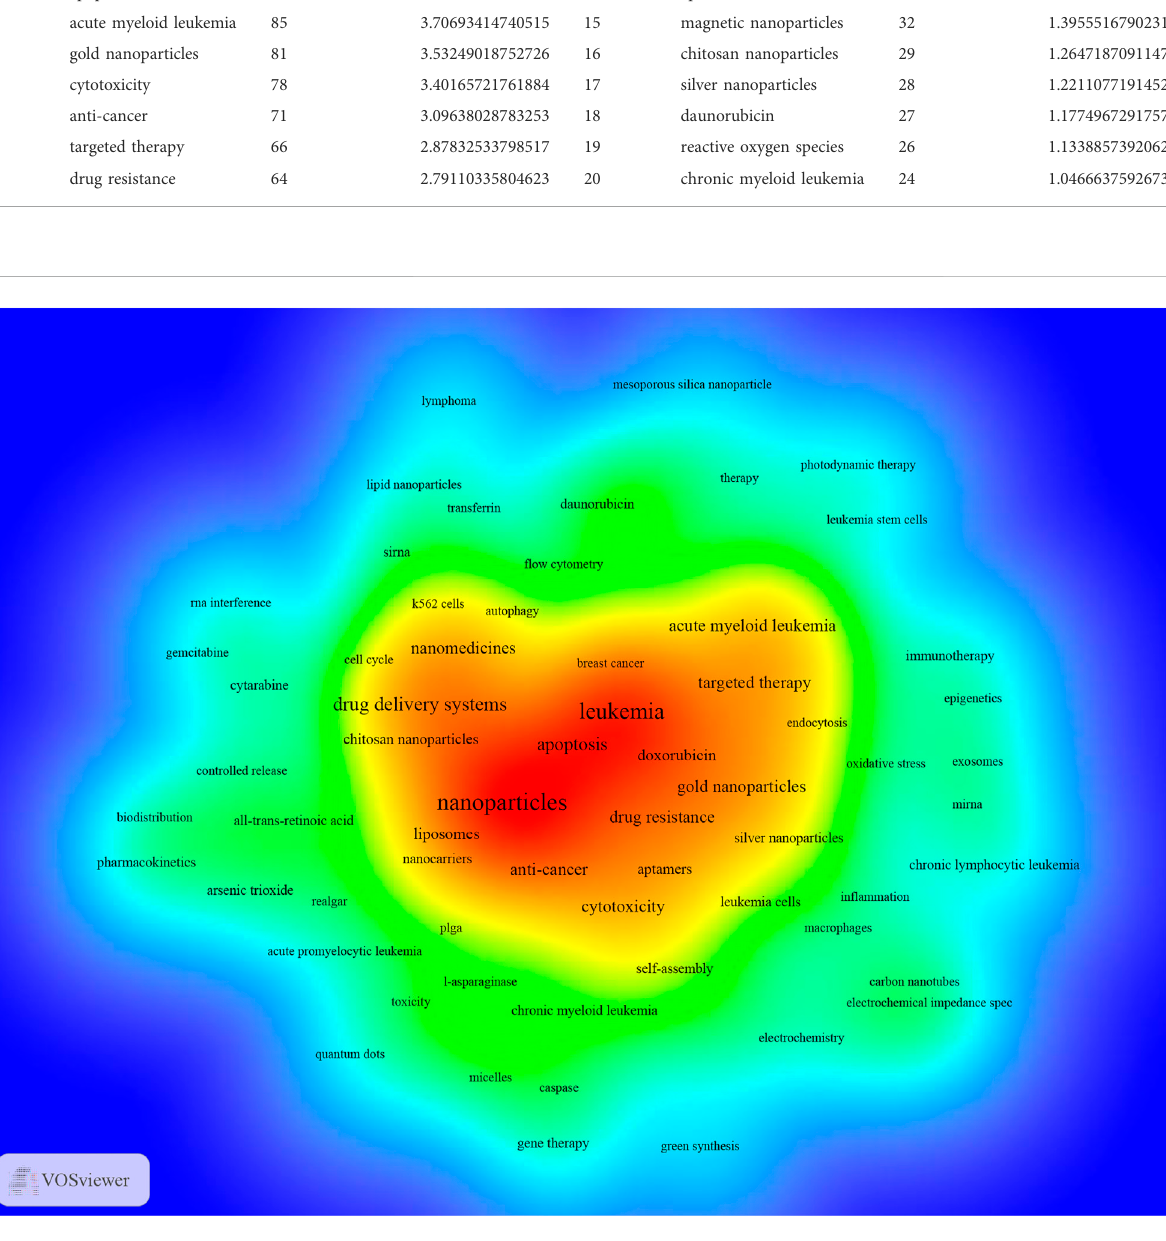
FIGURE 6 The density map of keywords in Nanoparticles-leukemia research (T ≥ 9). Notes: The word ’ s size, round, and red opacity positively relate to the co-occurrence frequency.